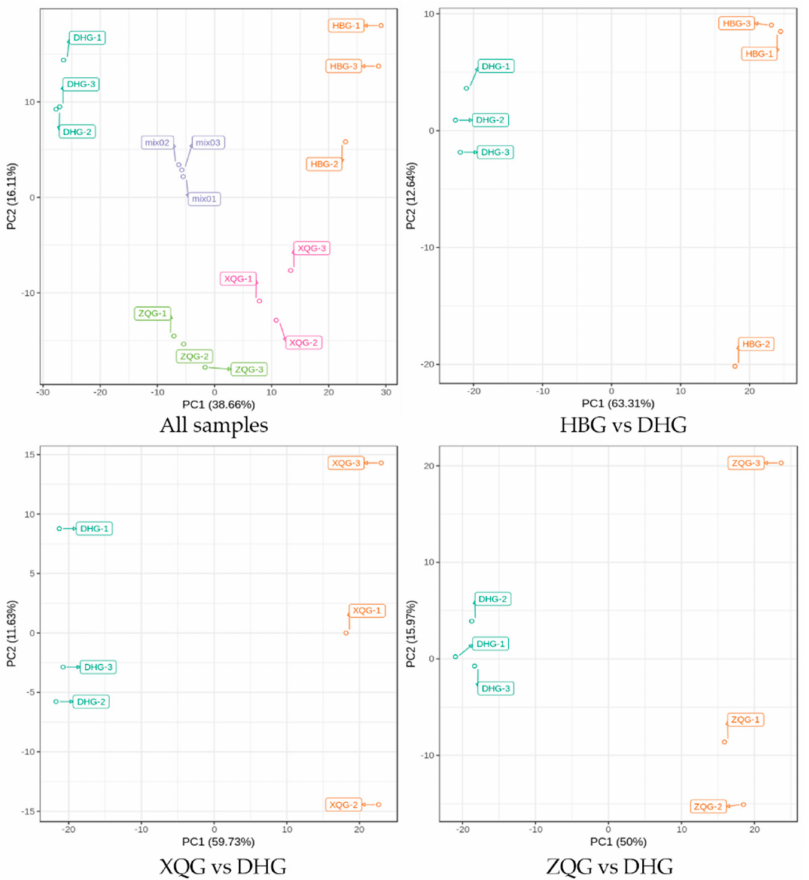
Figure 4. Principal component analysis (PCA) score plots for mass spectrum data of samples and quality control samples. The x axis represents the first principal component (PC1), and the y axis represents the second principal component